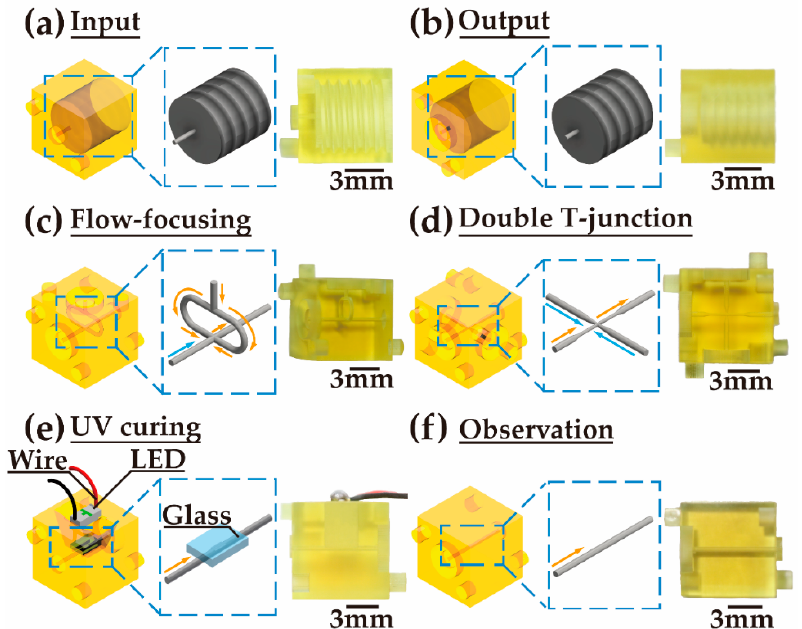
Figure 2. Schematic illustration of droplet generation modular components. ( a ) Input module. ( b ) Output module. ( c ) Flow-focusing module. ( d ) Double T-junction module. ( e ) UV curing module. ( f ) Observation module.